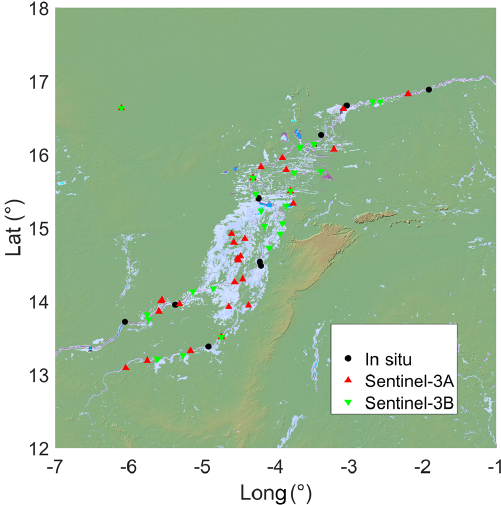
Figure 1. The Niger Inner Delta in Mali. Flooded areas appear in blue. They are made available by http://floodobservatory.colorado. edu/ (last access: 1 June 2021). Locations of in-situ gauges, and VS from Sentinel-3A and B are represented using black dots, red and green triangles,